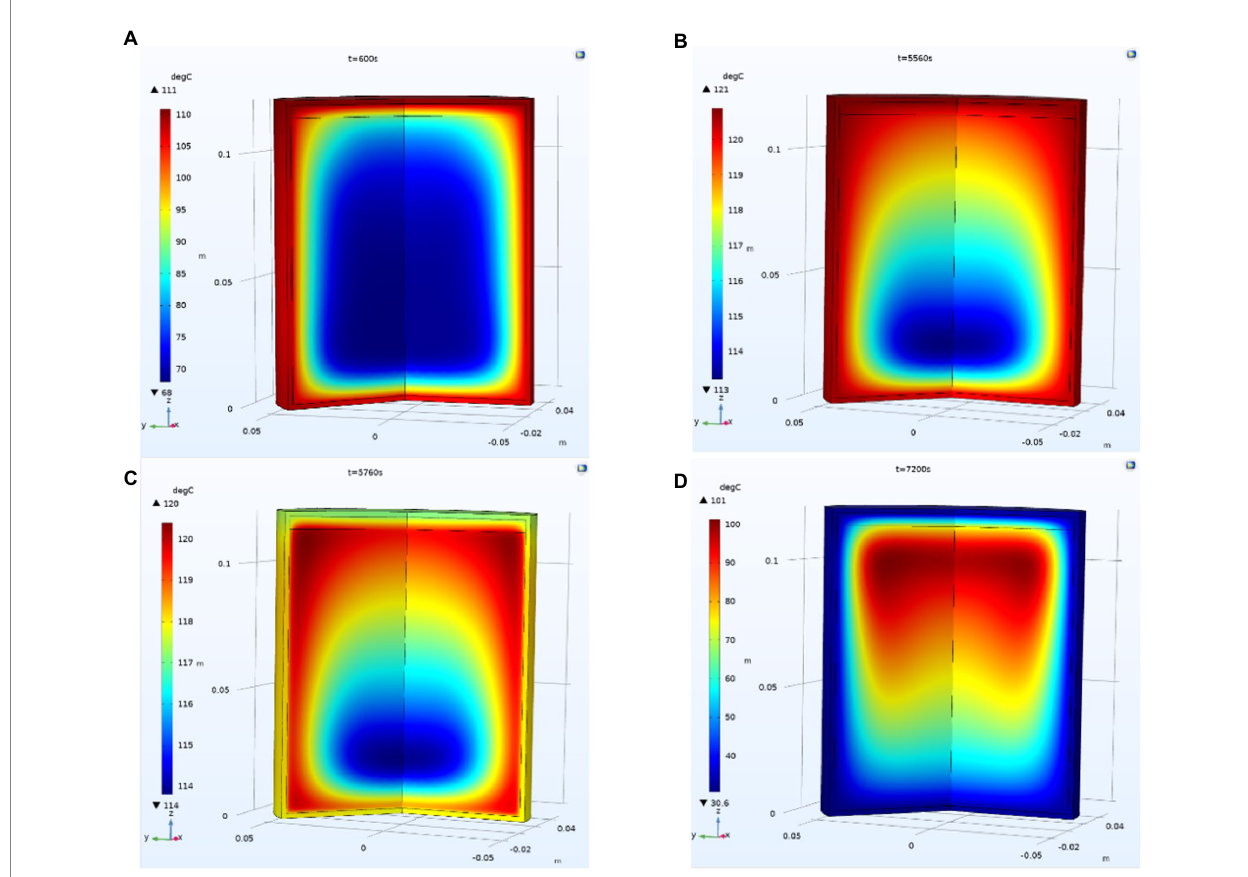
FIGURE. 2 Change in the temperature field in the can. (A) Temperature distribution in can when t = 600 s; (B) Temperature distribution in can when t = 5,560 s; (C) Temperature distribution in can when t = 5,760 s; (D) Temperature distribution in can when t = 7,200